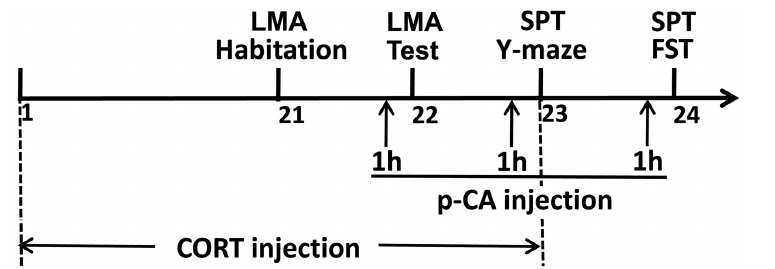
Figure 1. Schematic of the experimental design showing the timeline of drug injection and behavior tasks. CORT, corticosterone; FST, forced swimming test; LMA, locomotor activity; p-CA, p-coumaric acid; SPT, sucrose preference test.